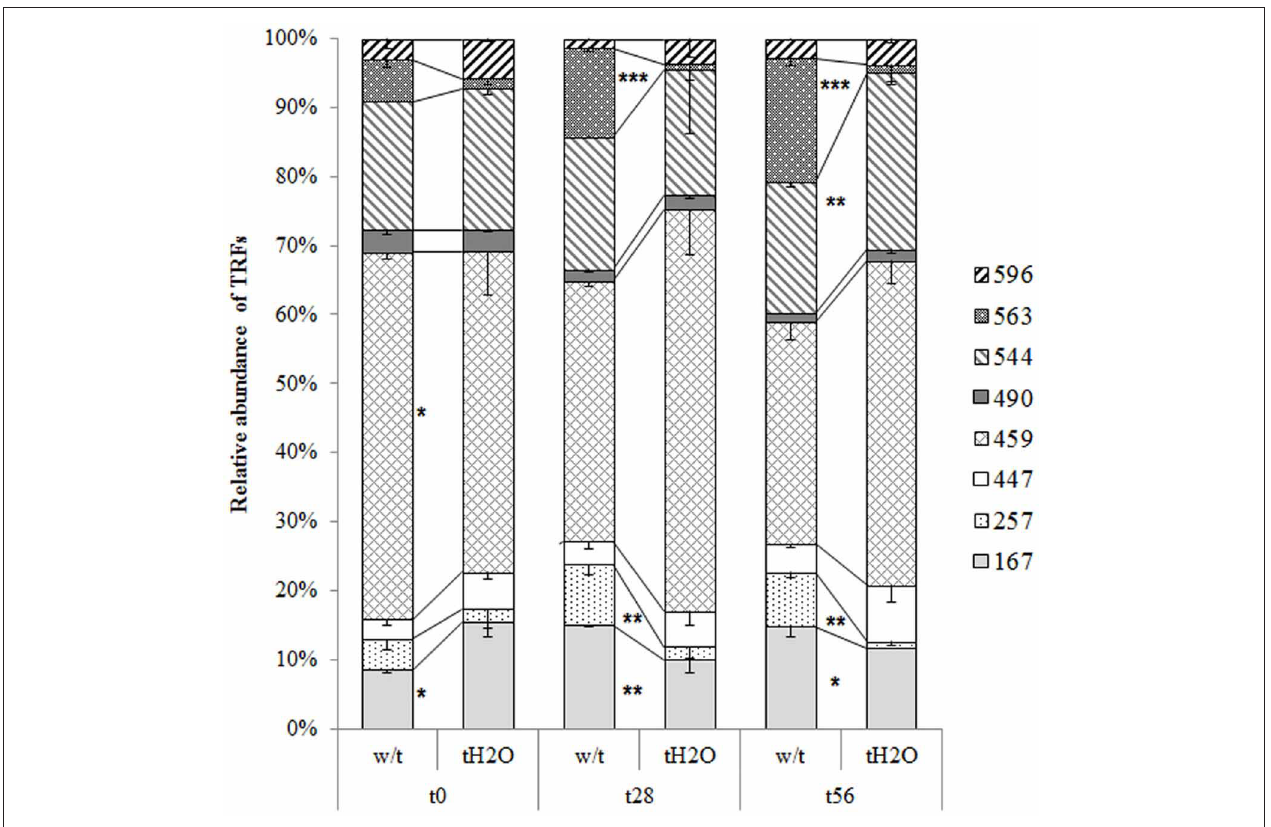
FIGURE 2 | Relative abundances (mean values; error bars represent standard deviation) of the AOA amo A genes T-RFs from microcosms without treatment (w/t) and microcosms treated with water each 14 days (tH2O) during the incubation time. The different